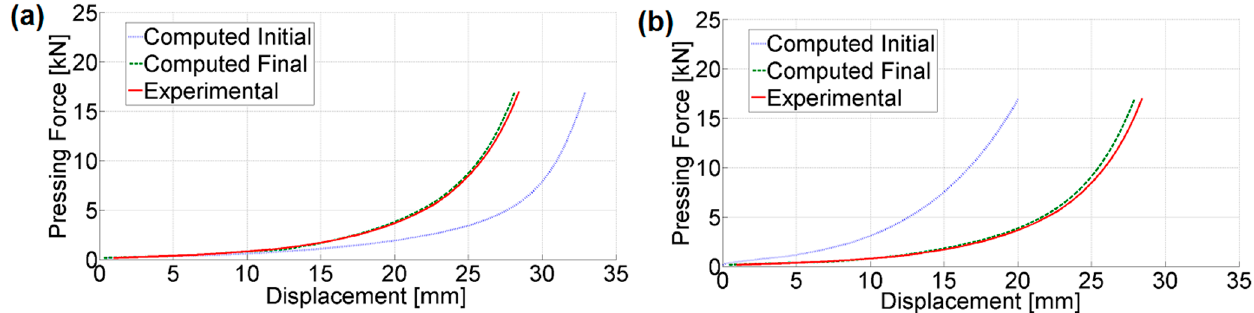
Figure 3. Computed test response vs. experimental response from two different inverse analysis results: ( a ) initialization 1; ( b ) initialization 2.